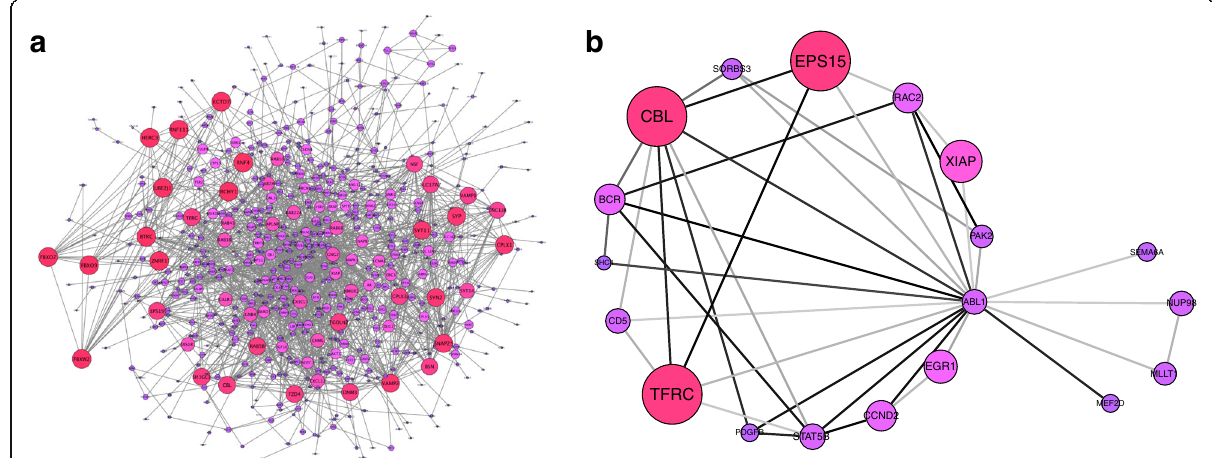
Fig. 2 Protein interaction network construction and module analysis of identified genes from osa-miR1858a and osa-miR1858b. a The protein interaction network of 721 identified genes; the color depth of the gene deepens with the “ degree ” of the node, and the size of the node and edges increases with the “ degree. ” b The first neighbors of selected nodes (ABL1) outgoing module in the network, including 19 nodes and 39 edges; the module function is closely related to the hemopoiesis, regulation of apoptotic process, regulation of cell population proliferation, and regulation of MAPK cascade